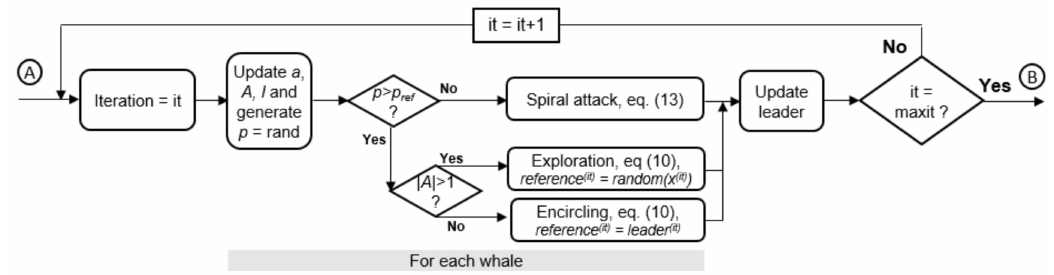
Figure 6. The flowchart of a WOA